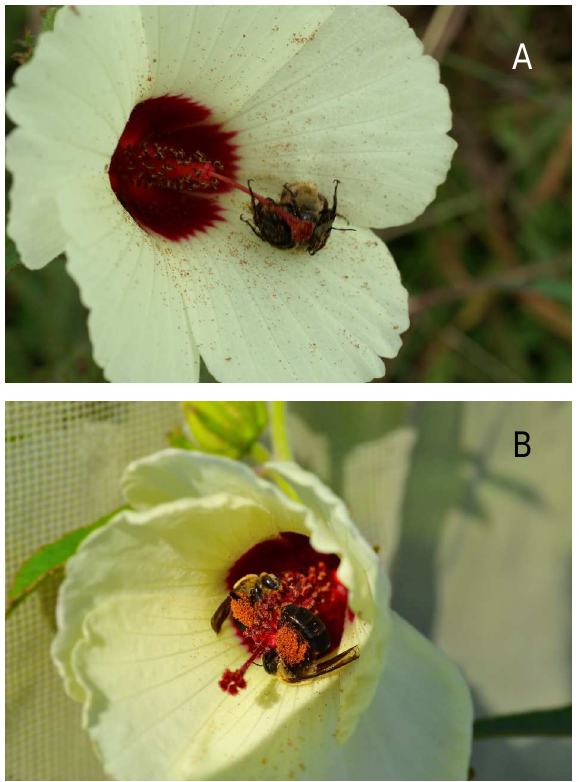
F IGURE 1. Intrafloral movements of Ptilothrix bombiformis . (A) A tussle between two male bees. Audible buzzes and grappling quite pronounced. Note the field of scattered pollen grains on the petals left by the two squabbling males and the bees close proximity to the stigma. (B) Co-visitation by two P. bombiformis females without significant